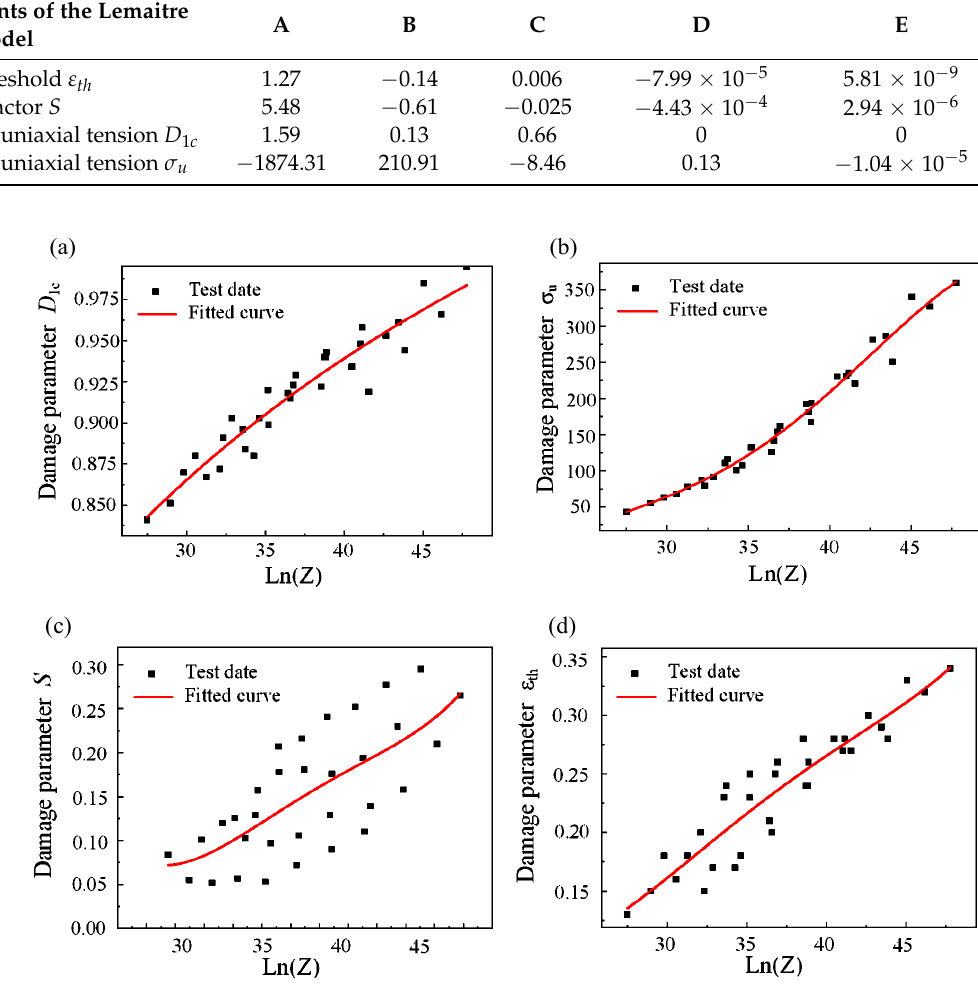
Figure 7. Fitting curve of coupling of Lemaitre damage model and Zener–Hollomon coefficient: ( a ) D 1 c -lnZ; ( b ) σ u -lnZ; ( c ) S -lnZ; ( d ) ε th -lnZ.